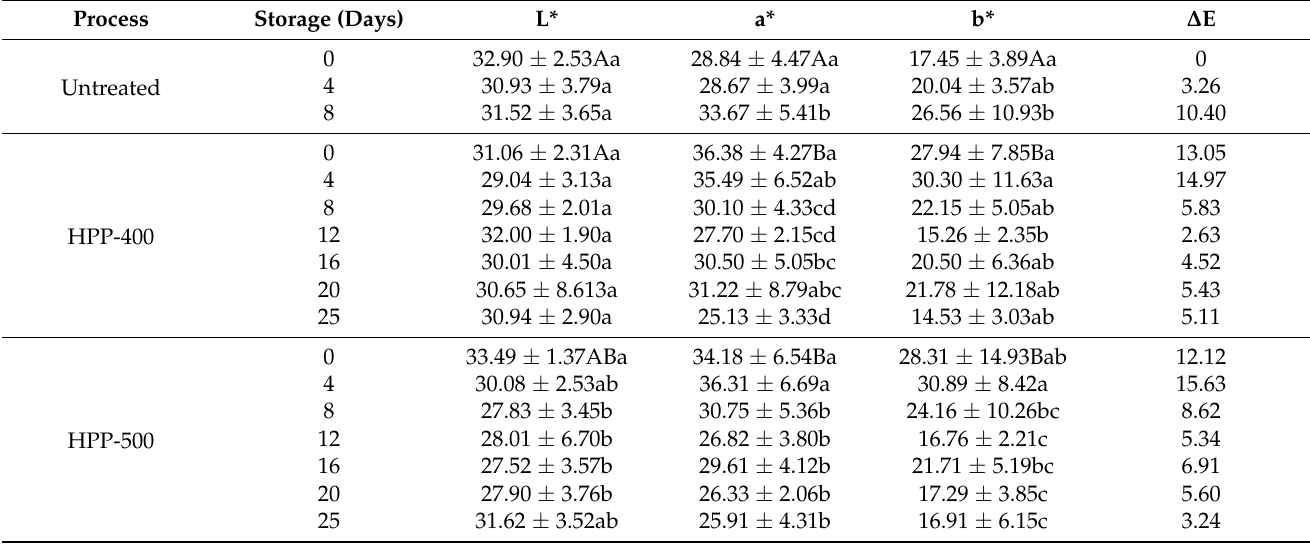
Table 4. Changes in the color parameters of fresh-cut bell pepper during storage at 4 ◦ C.